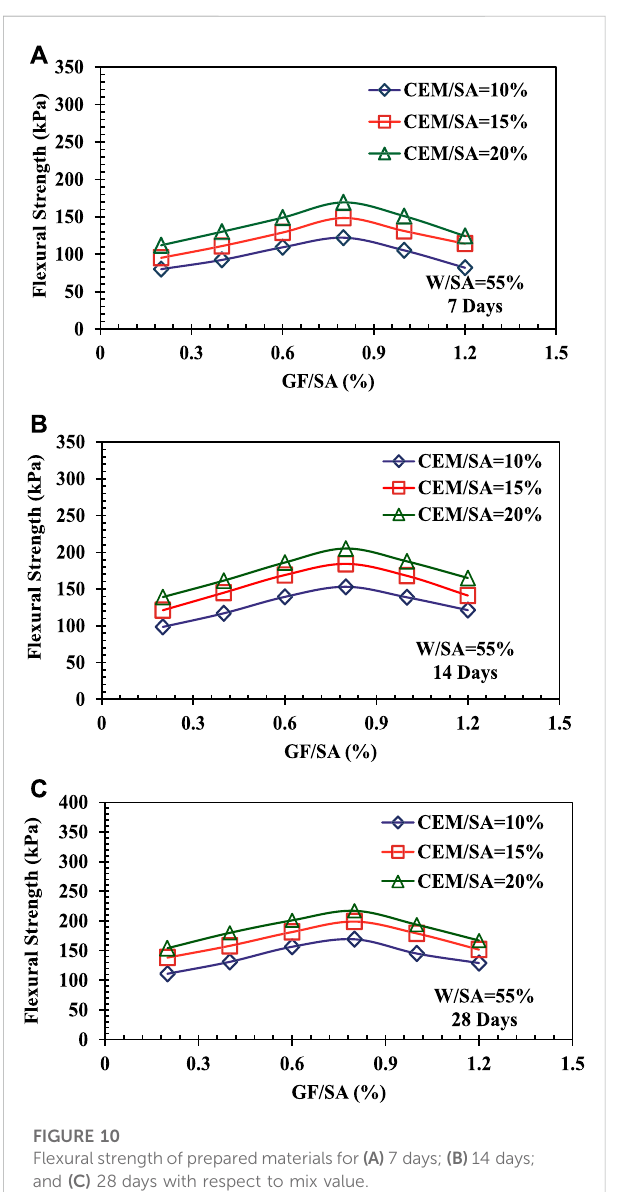
FIGURE 10 Flexural strengthof prepared materials for (A) 7 days; (B) 14 days; and (C) 28 days with respect to mix value.